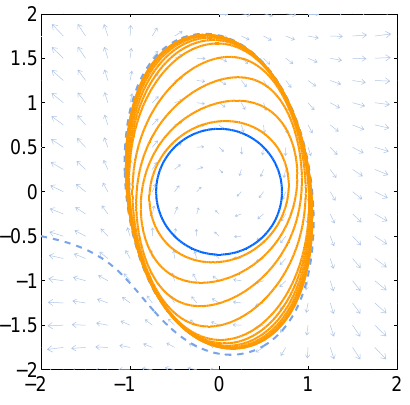
Figure 3. Successive iterates of the level-set